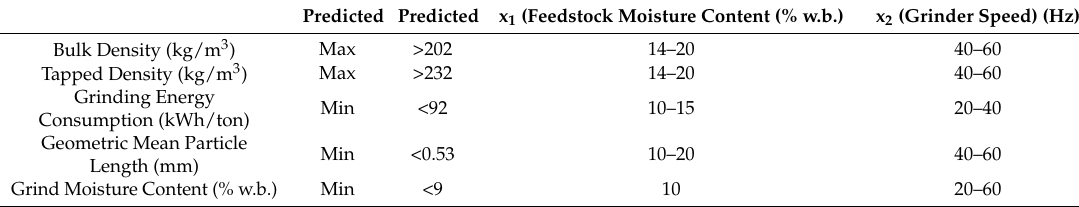
Figure 14. The effect of feedstock moisture content and grinder speed on specific energy consumption. Table 5. The trends of the process variables based on